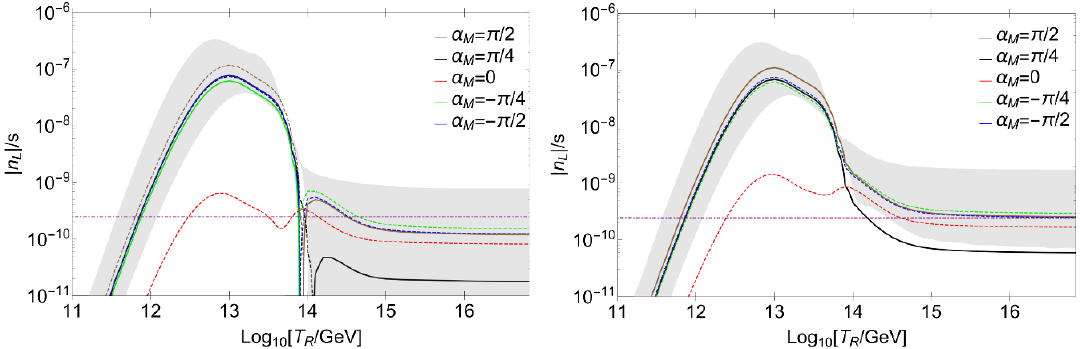
Figure 4 . Same as (cid:12)gure 3 but the lightest neutrino mass is m (cid:23) lightest = 0 : 07 eV, and the uncer- tainty is shown for (cid:14) = (cid:0) (cid:25)= 2 ; (cid:11) M = (cid:25)= 2 in the gray bands. We take (cid:11) M 2 = 0. ( (cid:11) = (cid:25)= 2) for (cid:12)gures 5 and 7 ((cid:12)gures 6 and 8). We took the same windows of M